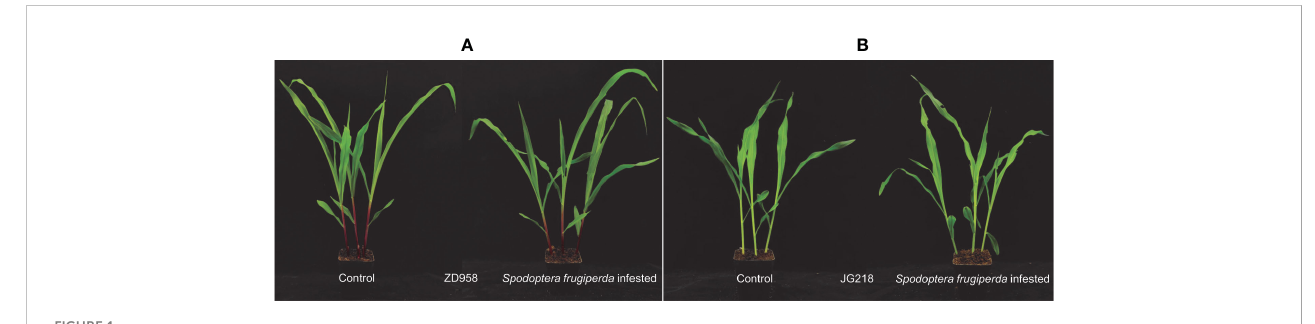
FIGURE 1 Infested and uninfested leaves (control) of maize from ZD958 (A) and JG218 (B)